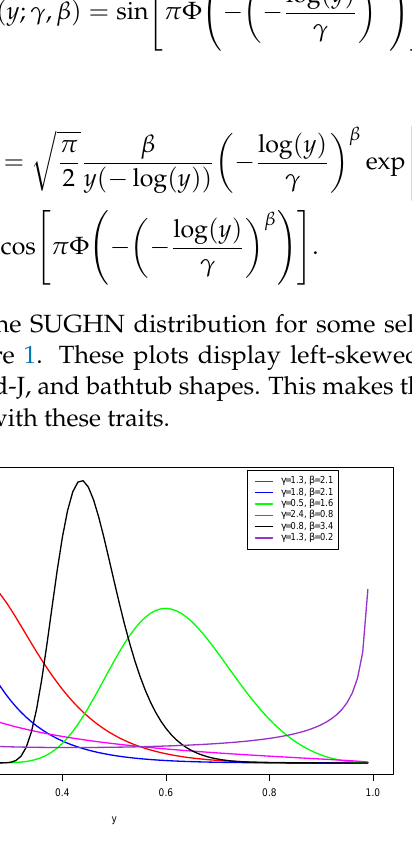
Figure 1. PDF plots of the SUGHN